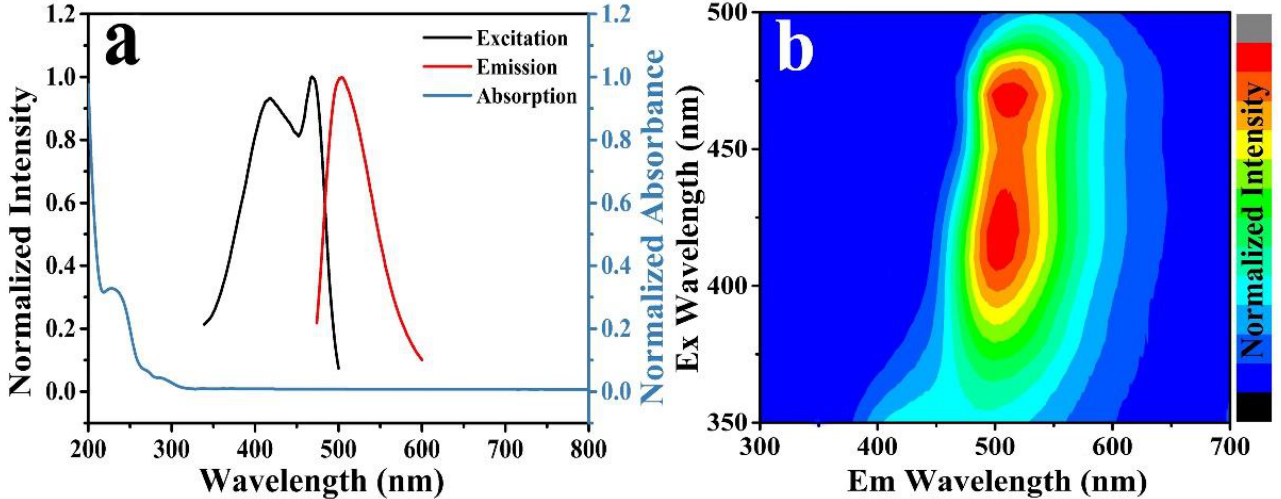
Figure 3. ( a ) UV-vis absorption (blue line), fluorescence excitation (black line), and emission spectra (red line) of the N, F-CDs in an aqueous solution. ( b ) The excitation-emission map of the N, F-CDs aqueous solution in the excitation range of 300 – 600 nm.